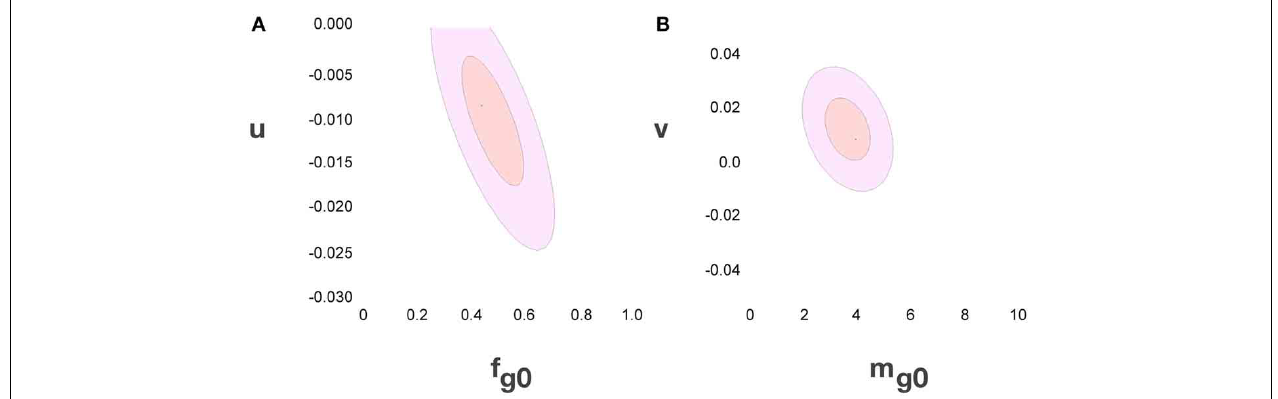
FIGURE 3 | Uncertainty ellipses for parameters in the model. (A) Estimates for u and fg 0 . (B) Estimates for v and mg 0 . The values that minimize the χ 2 function are u = − 0 . 010 ± 0 . 005 pg − 1 , v = 0 . 017 ± 0.009, f g0 = 0.48 ± 0.08 and m g0 = 3.6 ± 0.8pg.